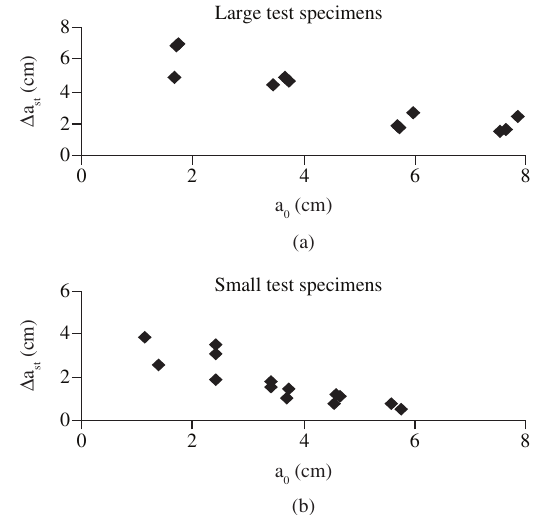
Figure 8. Extent of stable crack propagation, ∆ a a a) for large test specimens; and b) for small test 0;